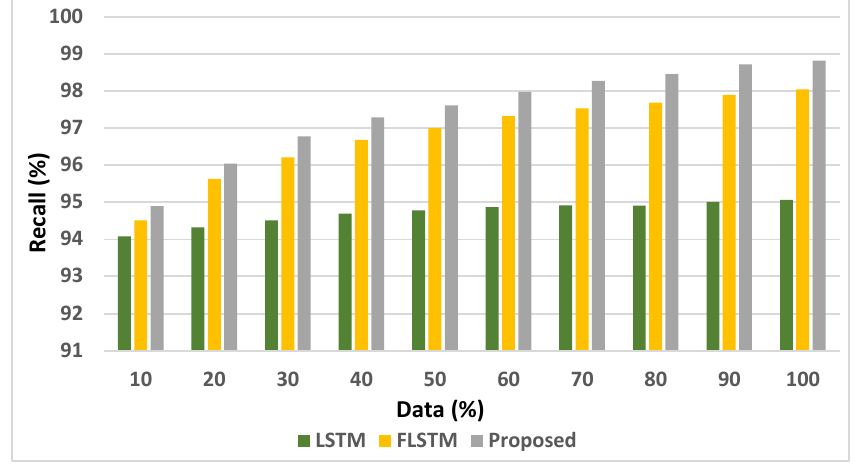
Figure 7. Recall analysis.